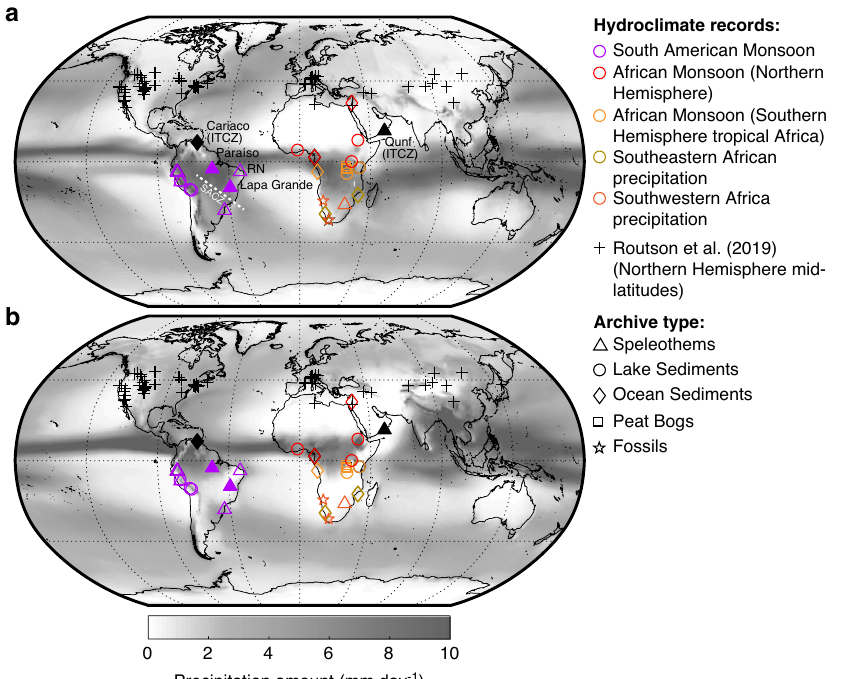
Fig. 2 Spatial distribution of the Holocene hydroclimate records utilised in this study. The symbols indicate the location and archive type of individual hydroclimate proxy records, including the Northern Hemisphere mid-latitude hydroclimate proxy records of ref. 3 . Filled symbols indicate locations, where the record was omitted for the calculation of composite records (see ‘ Methods' section). a Mean precipitation amount from December to March and b from June to September calculated from the ERA-Interim Reanalysis dataset using the years 1979 – 2015 49 . Each site is listed in Supplementary Data 1 and 2, including the individual hydroclimate dataset used in this study and related